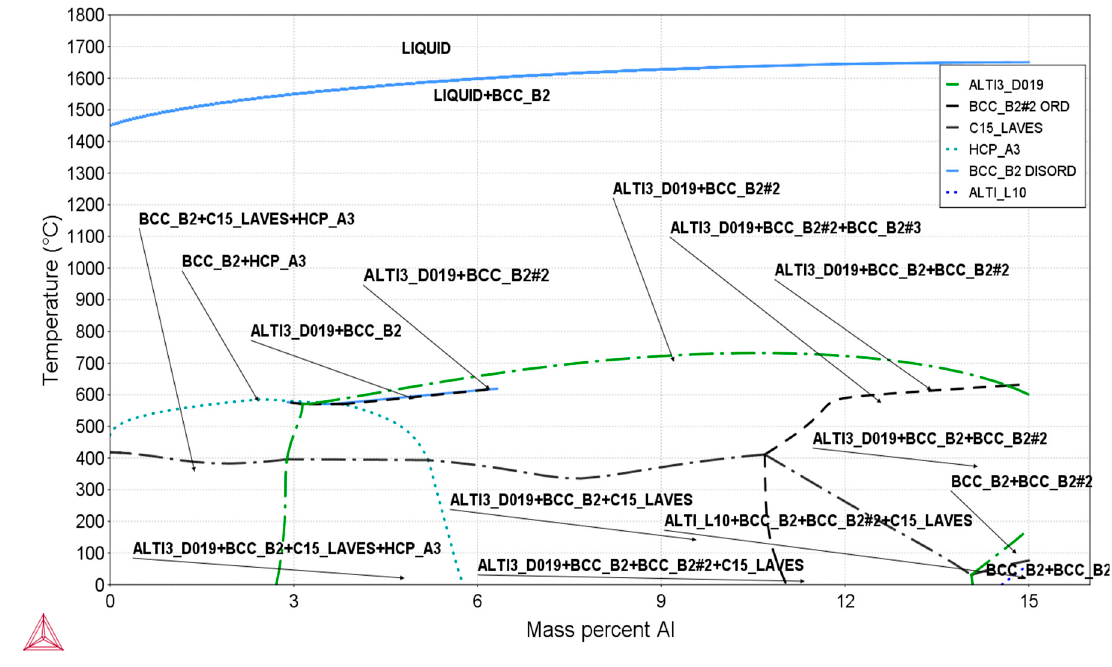
Figure 1. Phase diagram for one of the alloys from the Ti–Cr–Al–V system.